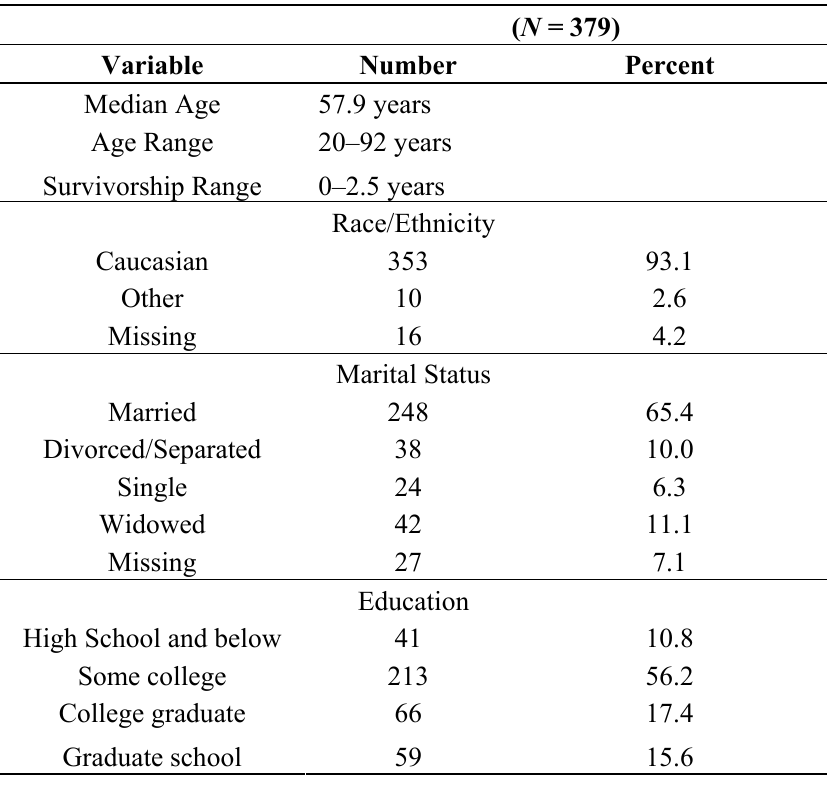
Table 1. Baseline Demographics